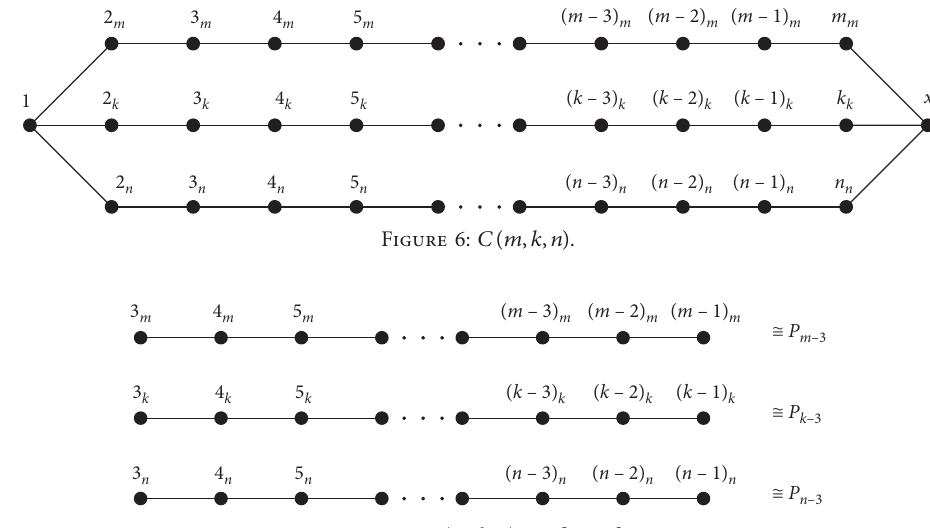
Figure 7: C ( m,k,n ) − N [ 1 , x { } ] .